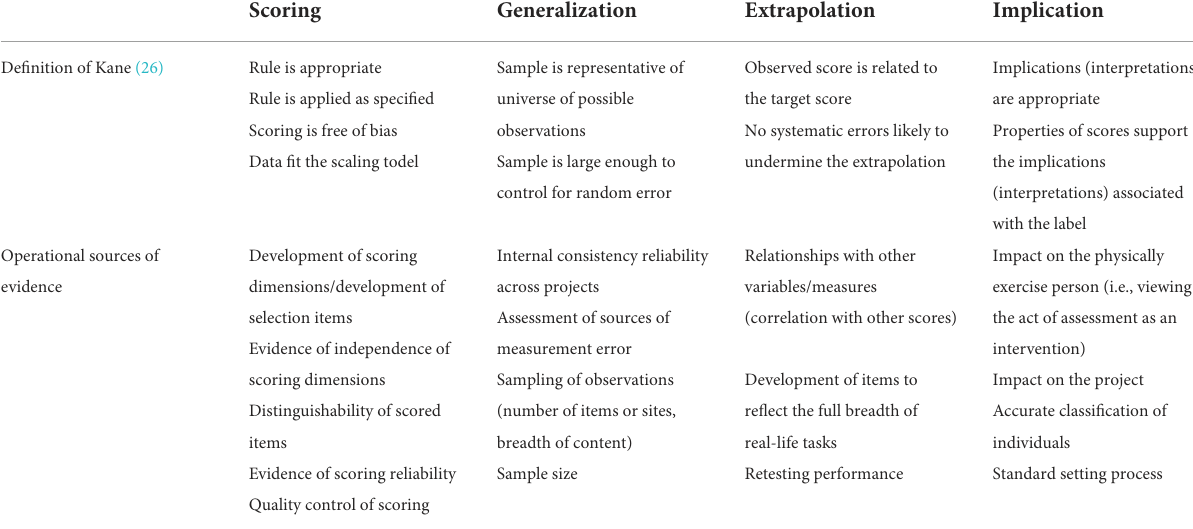
TABLE 1 Specific evidence to support validity